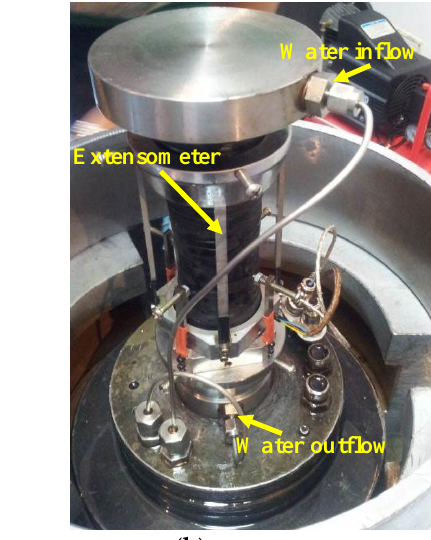
Figure 4. Axial stress-strain curves of the hydro-mechanical experiments affected by different water pressures. ( a ) σ 3 = 5.0 MPa; ( b ) σ 3 = 10.0 MPa.